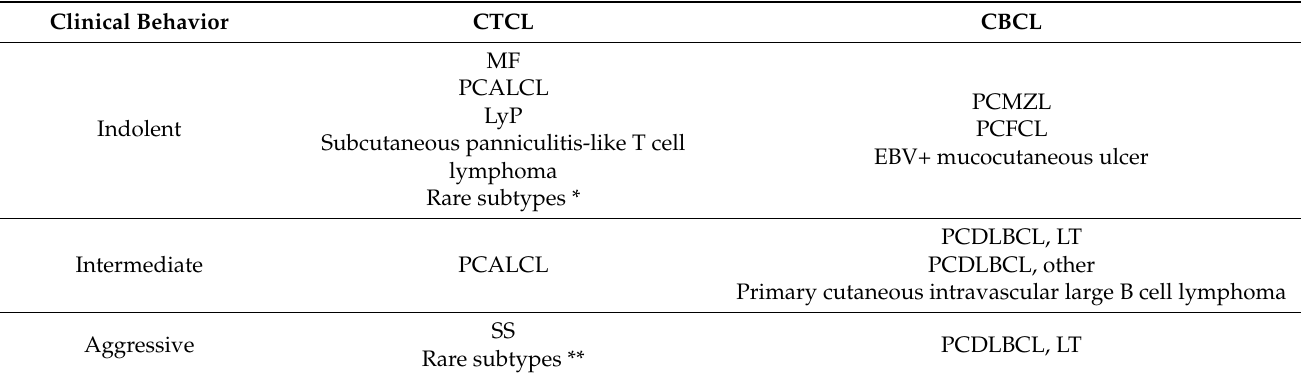
Table 1. Classification of primary cutaneous lymphomas according to clinical behavior, following the WHO-EORTC classification and its 2018